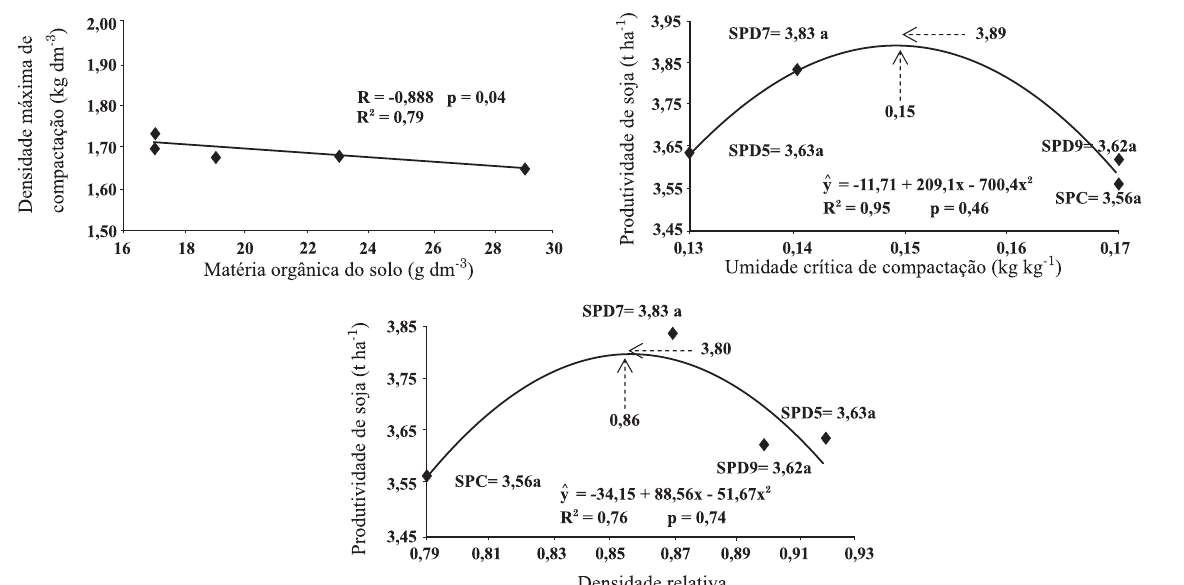
Figura 5. correlações entre matéria orgânica do solo e densidade máxima de compactação, umidade crítica de compactação e produtividade de soja e densidade relativa do solo entre a produtividade de soja na camada de 0–0,10